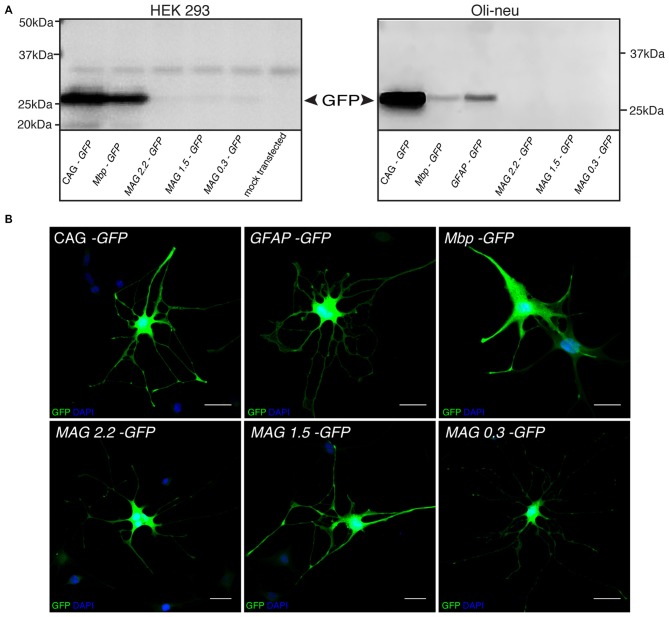
MAG promoter selectivity in vitro. (A) GFP Immunoblots of HEK 293 and Oli-neu cells transiently transfected with the indicated plasmids. (B) Immunofluorescence detection of GFP expression following dbcAMP-induced differentiation of Oli-neu cells transfected with the indicated plasmids. Activity of the GFAP promoter was restricted to cells with astroglial morphology while the other promoters drove transgene expression in cells exhibiting oligodendrocyte morphology. Representative results of three independent experiments are shown. Bars: 30 μm.